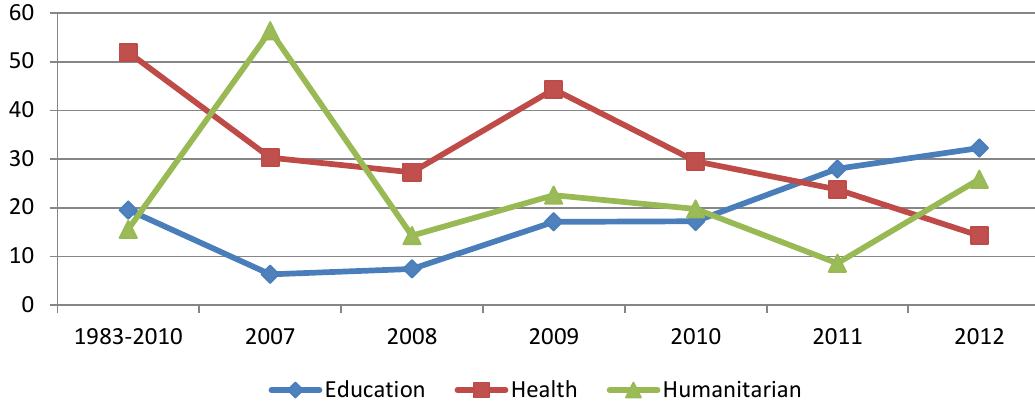
Source: Compiled by the authors from annual